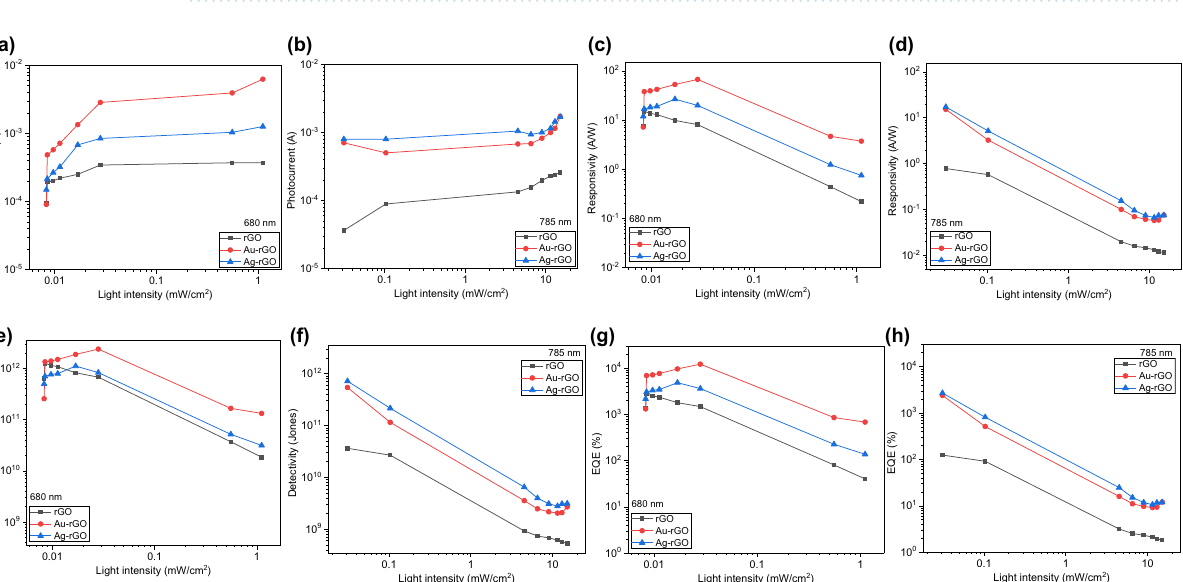
Figure 5. ( a , b ). Plot of net photocurrent versus light intensity under laser illumination at 680 nm and 785 nm. ( c , d ) The power-dependent responsivity. ( e , f ) The light density-dependent detectivity of ( g , h ) External quantum efficiency, EQE versus optical power density of the